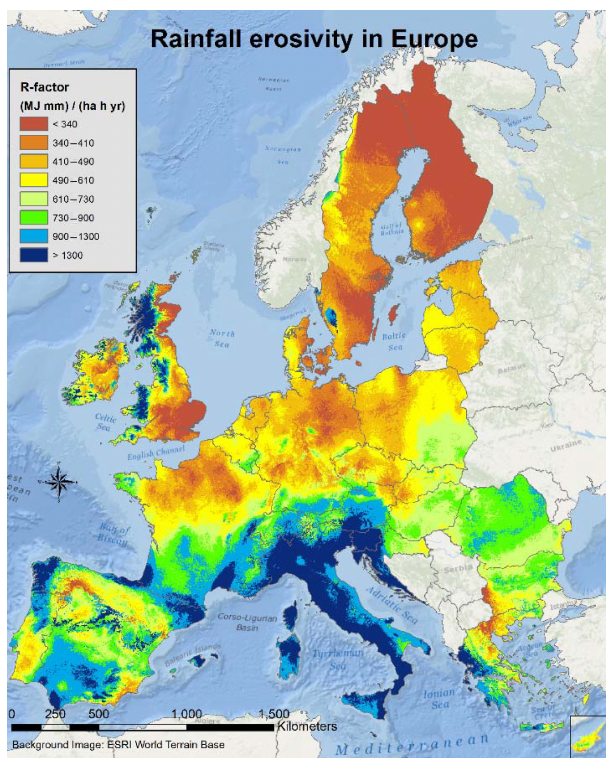
Figure 11. Rainfall erosivity in Europe at 1km grid cell resolu- tion. Source: Panagos et al. (2015). Creative Commons Attribution- NonCommercial-NoDerivatives License (CC BY-NC-ND, https:// doi.org/10.1016/j.scitotenv.2015.01.008; last access: 11 September